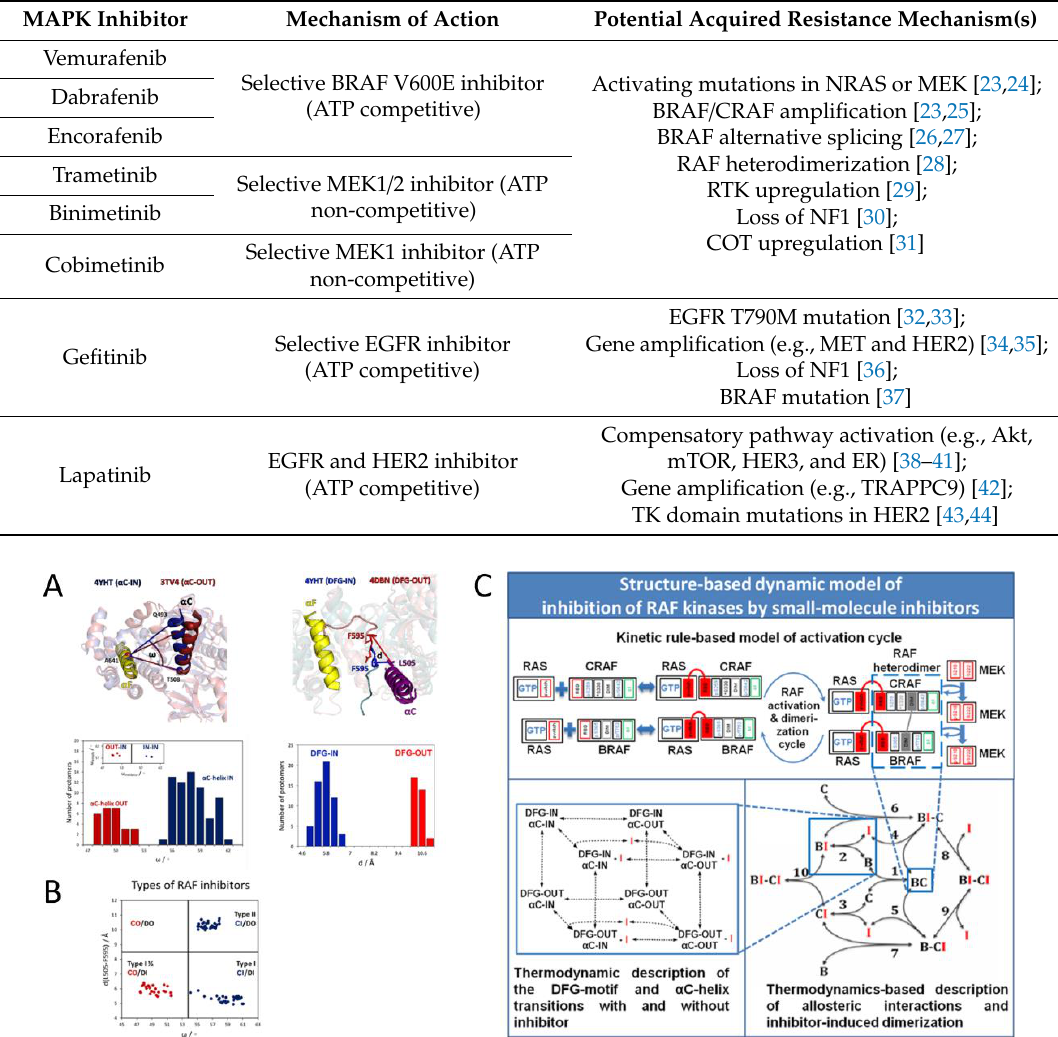
Table 1. The mechanisms of action and acquired resistance to MAPK inhibitor drugs. Note that MEK inhibitors are used in combination with BRAF inhibitors.